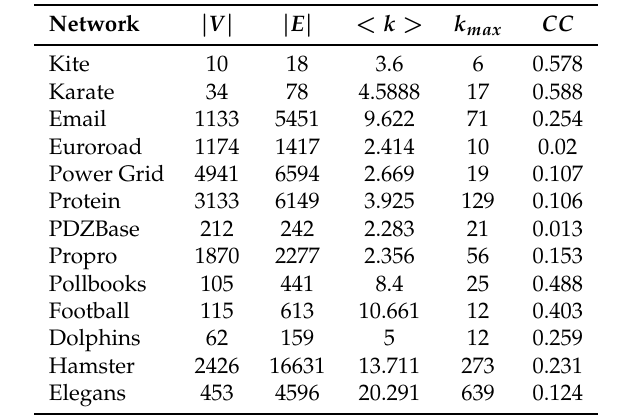
Table 4. Data sets. | V | and | E | indicate the number of nodes and edges, respectively; < k > and k max represent the average degree and the maximum degree, respectively; and CC is the average clustering